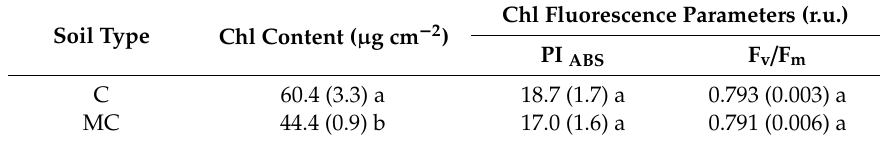
Table 4. Leaf chlorophyll content and chlorophyll fluorescence parameter analysis (the quantum yield of primary photochemistry (F v / F m ) and performance index (PI ABS ) of PS II) in hemp plants ( Cannabis sativa L., cv. Codimono) after 90 days of growth in a greenhouse in pots filled with soil sampled in two di ff erent sites (C and MC) in the “Valle del Sacco” area (Lazio Region, Central Italy). In each column, mean values (n = 4 ± SE) are reported. Di ff erent letters indicate significantly di ff erent values (t-test, p ≤ 0.05).